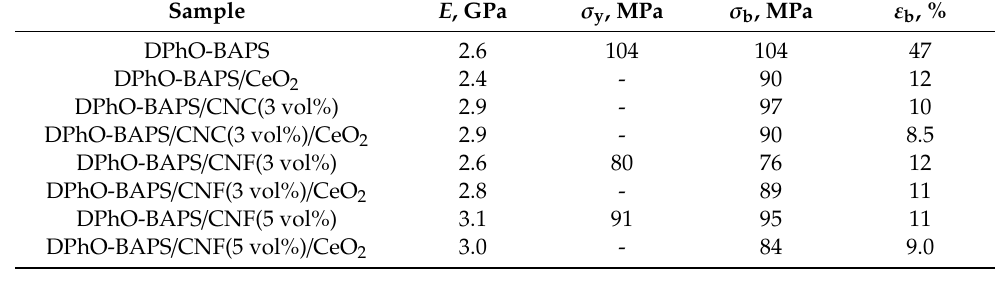
Table 5. Mechanical properties of the DPhO-BAPS-based compositions.